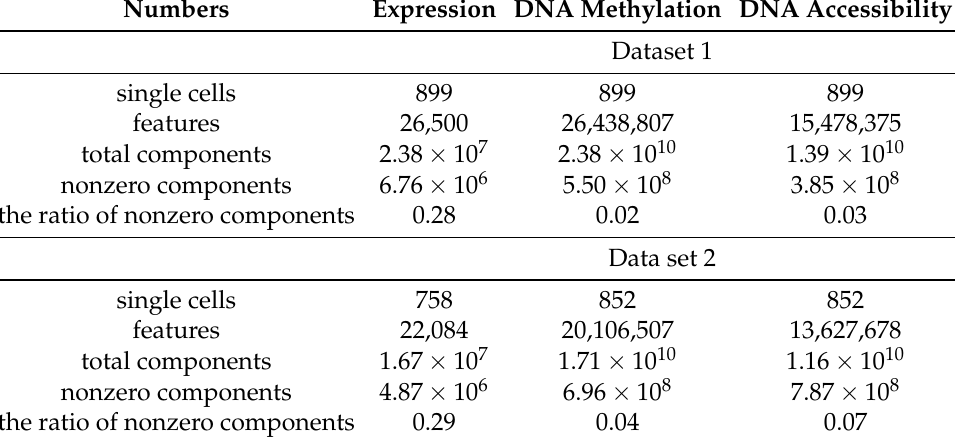
Table 5. Number of single cells, features, nonzero components, and their